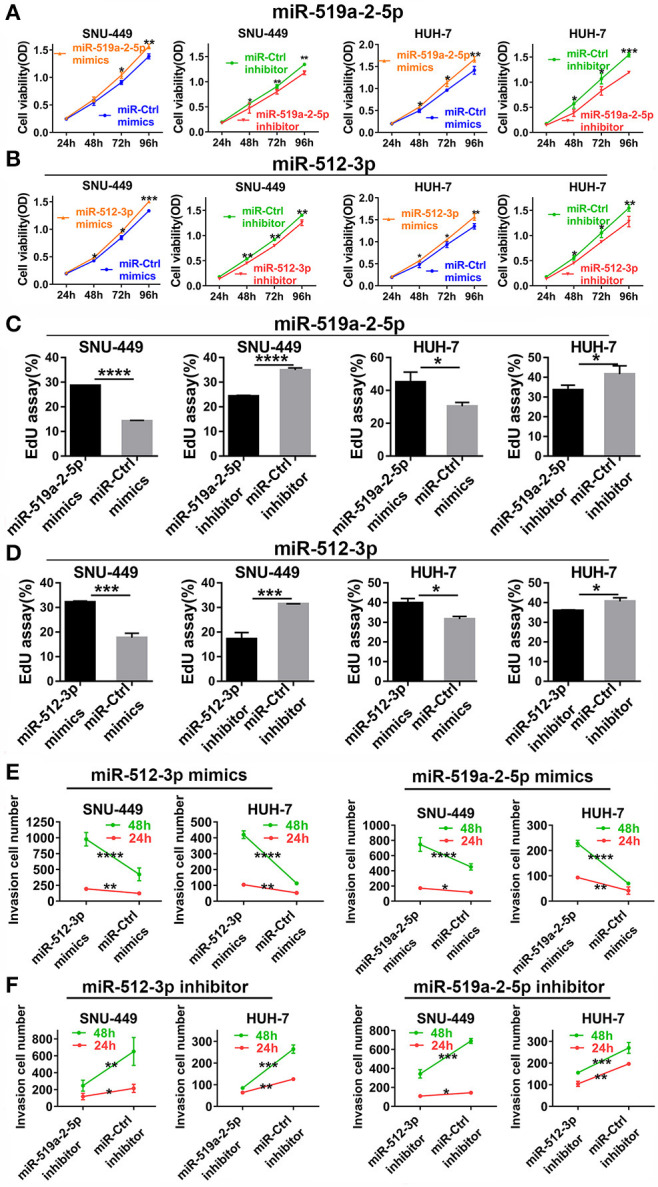
MiR-519a-2-5p and miR-512-3p promoted hepatocellular carcinoma proliferation and invasion in vitro. (A,B) CCK-8 assay detected the change of HCC cell proliferation after transfected with miR-519a-2-5p (A) or miR-512-3p (B) mimics, inhibitor, and their controls. (C,D) EdU assays showed the effects of miR-519a-2-5p (C) or miR-512-3p (D) on HCC cells after transfected with the mimics, inhibitor, or their controls, respectively. (E,F) Line charts showed that the invasion capacity (at time of 24 and 48 h) of HCC cells was changed after transfected with miR-519a-2-5p (E) or miR-512-3p (F) mimics, inhibitor, or the controls. The statistics analysis was performed with Student's t-test. “*”, “**”, “***” and “****” represented the p-value < 0.05, 0.01, 0.001 and 0.0001, respectively.